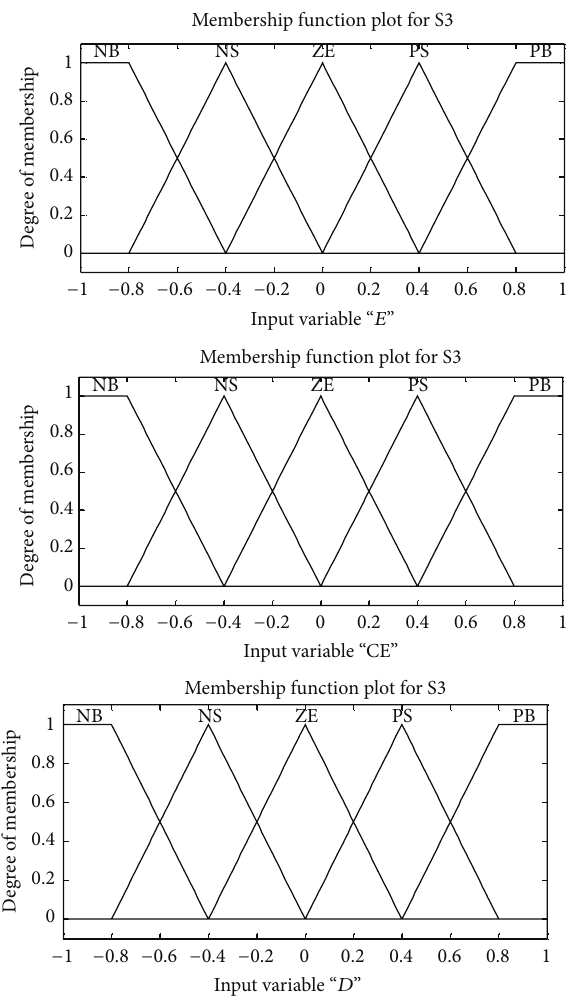
Figure 11: The membership functions of 𝐸 , CE, and 𝐷 for